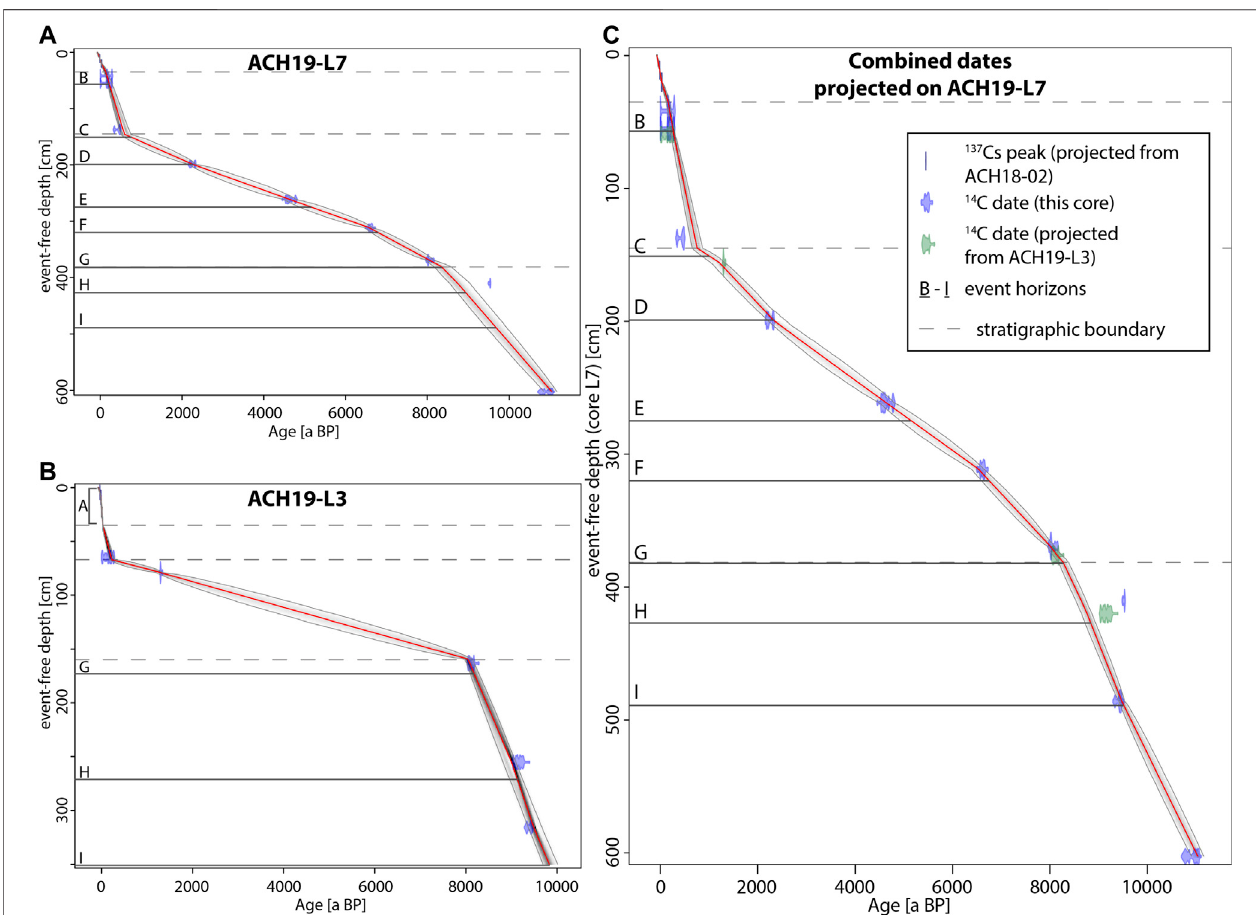
FIGURE10| Age-depthmodelsofcoresACH19-L7 (A) andACH19-L3 (B) basedoncombined 137 Cspeaksand 14 Cdates. (C) Age-depthmodelofcoreACH19- L7 contains projected ages from ACH19-L3 (colored green) based on core-to-core correlation ( Figure 9 ). Mean age is indicated by red line and grey zone depicts 95% probability range. Event deposits > 5 cm were identi fi ed and excluded resulting in an event-free sediment depth. Events corresponding to seismic-stratigraphic event horizons B-I are indicated by horizontal black lines.